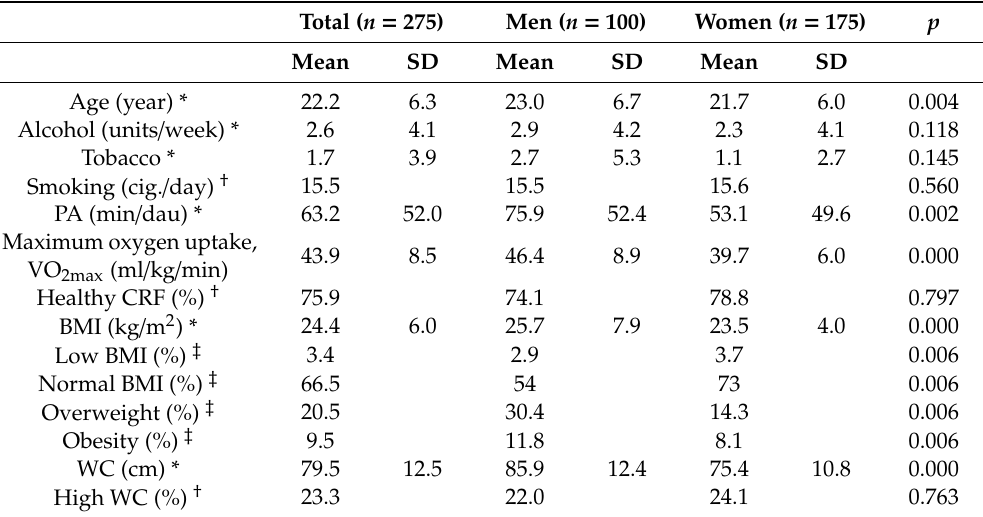
Table 1. Characteristics of the participants according to